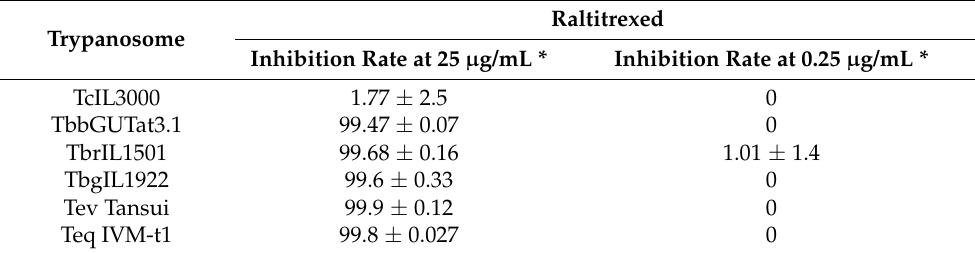
Table 1. The inhibition rate of raltitrexed at 0.25 or 25 µ g/mL against 6 Trypanosoma species, TcIL3000,